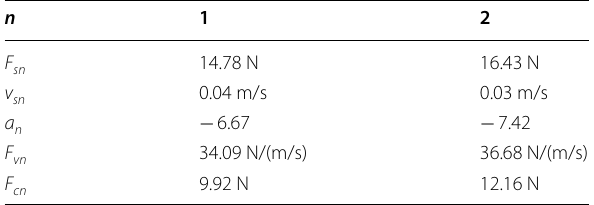
Table 4 Parameters of friction